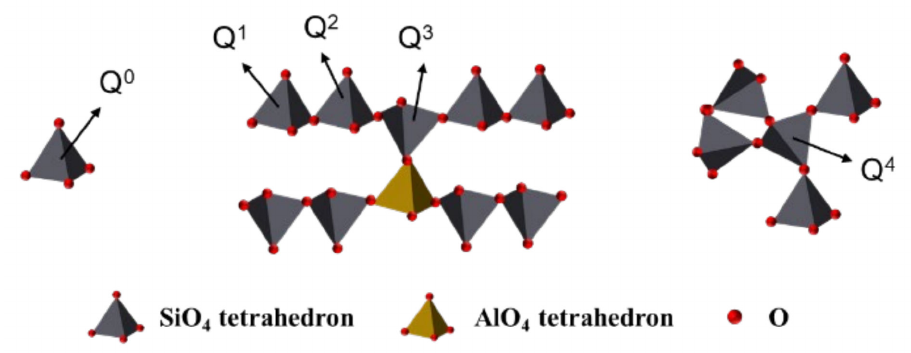
Figure 6. Silicon chain structure in C-S-H